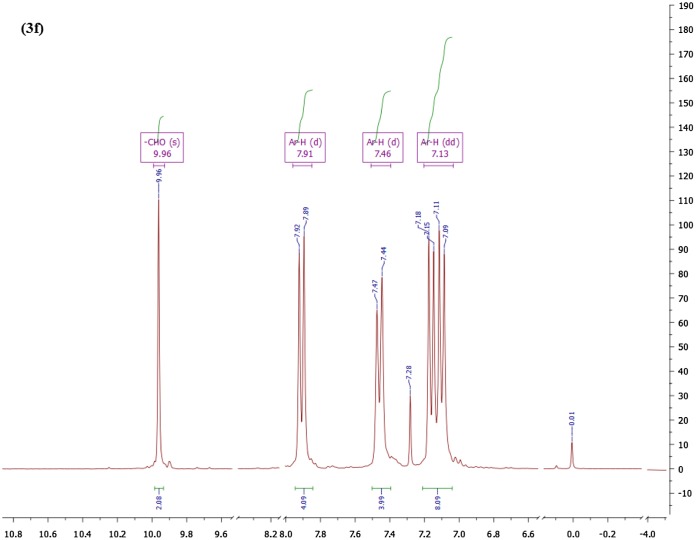
Proton NMR of monomer 3f in CDCl3
.